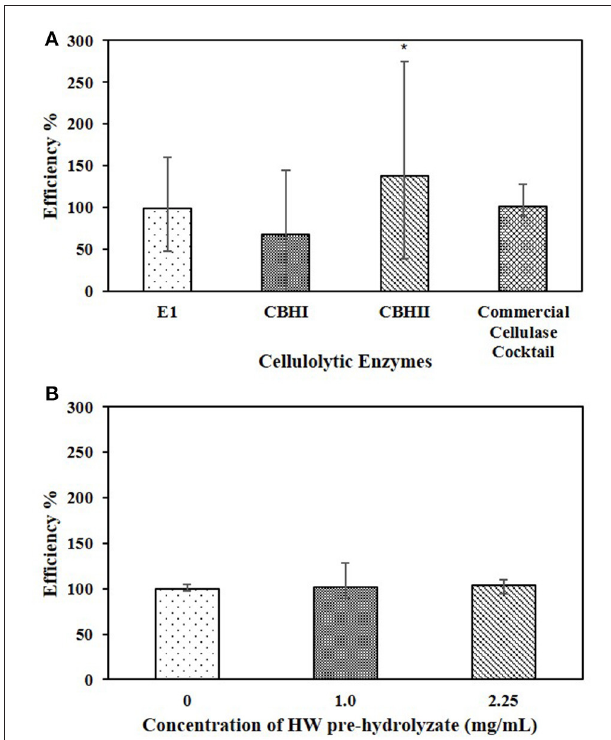
FIGURE 4 | (A) Effects of 1.0 mg/mL whole HW pre-hydrolyzate on E1, CBHI, CBHII, and commercial cellulase cocktail during the cellulose-DNS assay. (B) Effects of different concentration of whole HW pre-hydrolyzate on commercial cellulase cocktail during the cellulose-DNS assay. Symbol * represents the level of significance according to the double tailed t -test. Standard error bars were used to represent the deviation.